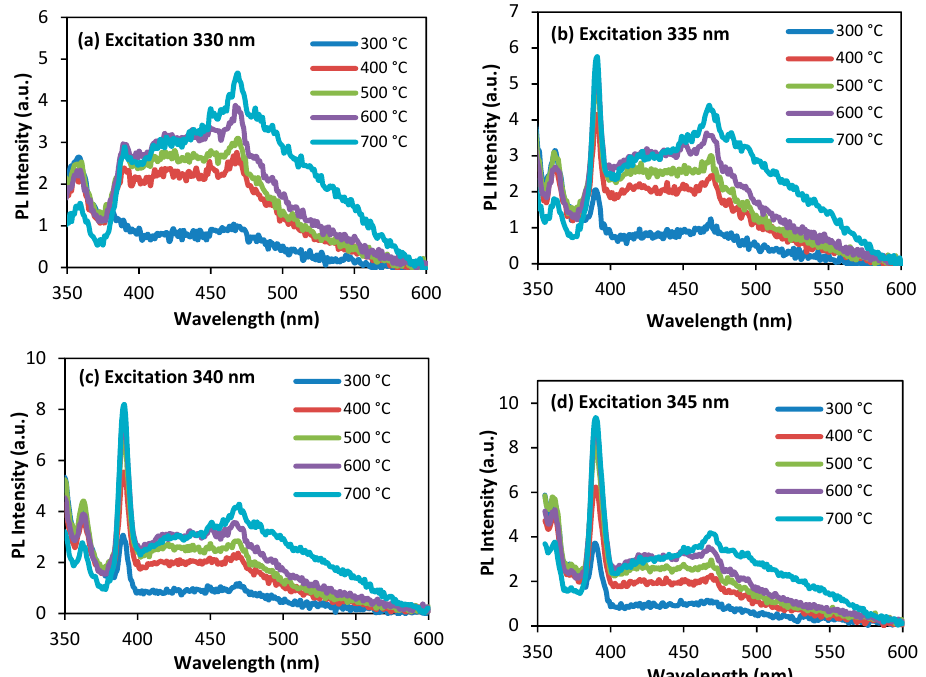
Figure 7. Photoluminescence spectra for Ag/ZnO at different calcination temperatures. Excitation source: ( a ) 330, ( b ) 335, ( c ) 340, ( d ) 345 nm.